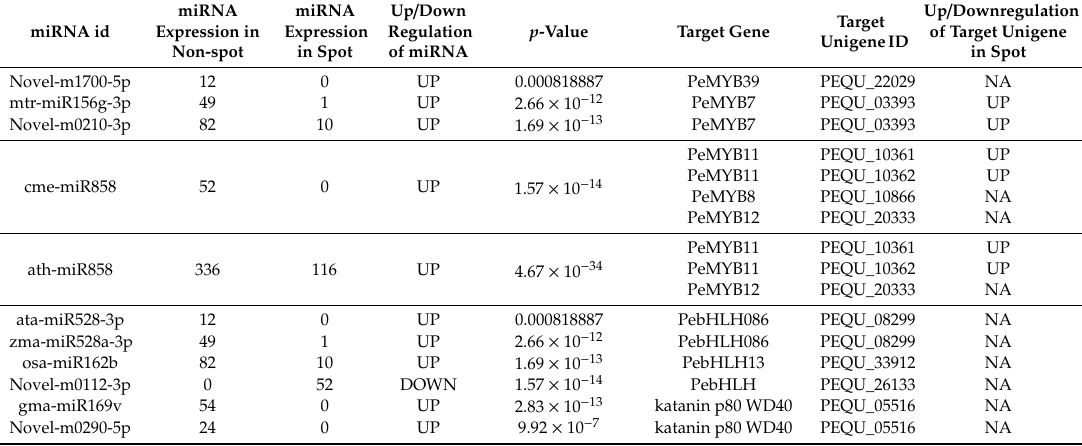
Table 3. Putative miRNAs targeting on MYB , bHLH or WRKY unigenes.